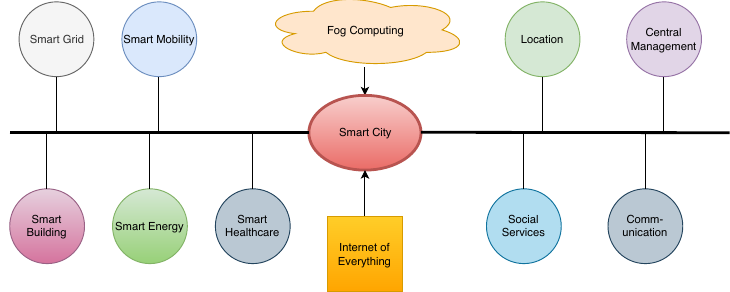
Figure 1. Smart City